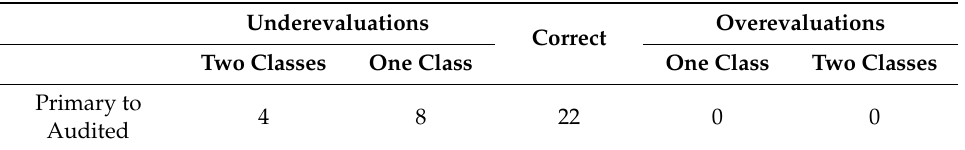
Table 6. Comparison of primary and audited classifications. Underevaluation occurs when primary classification is lower than the audited classification, with the opposite for overevaluation. When both classifications match, it is considered as